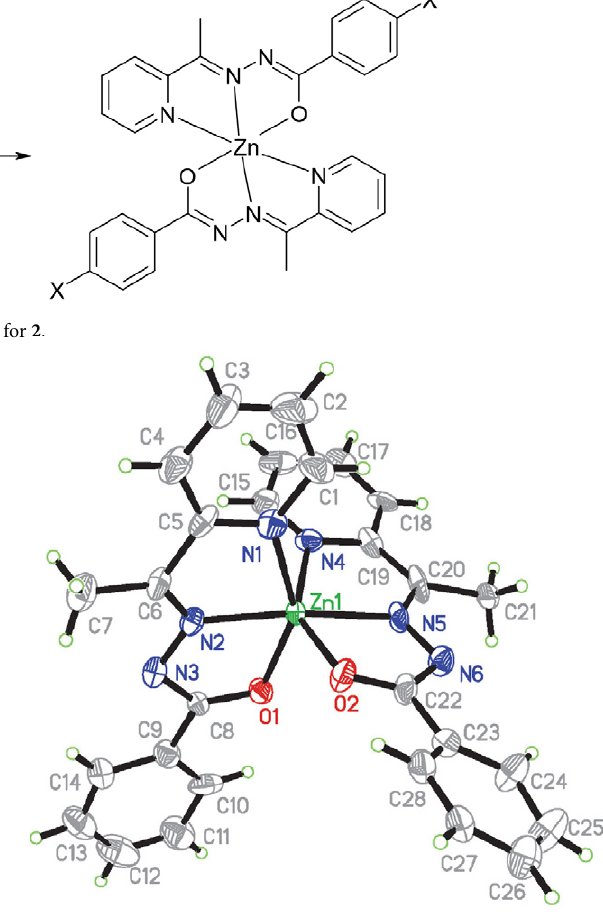
Figure 2. Molecular structures of complex 2 with ellipsoids at 30%